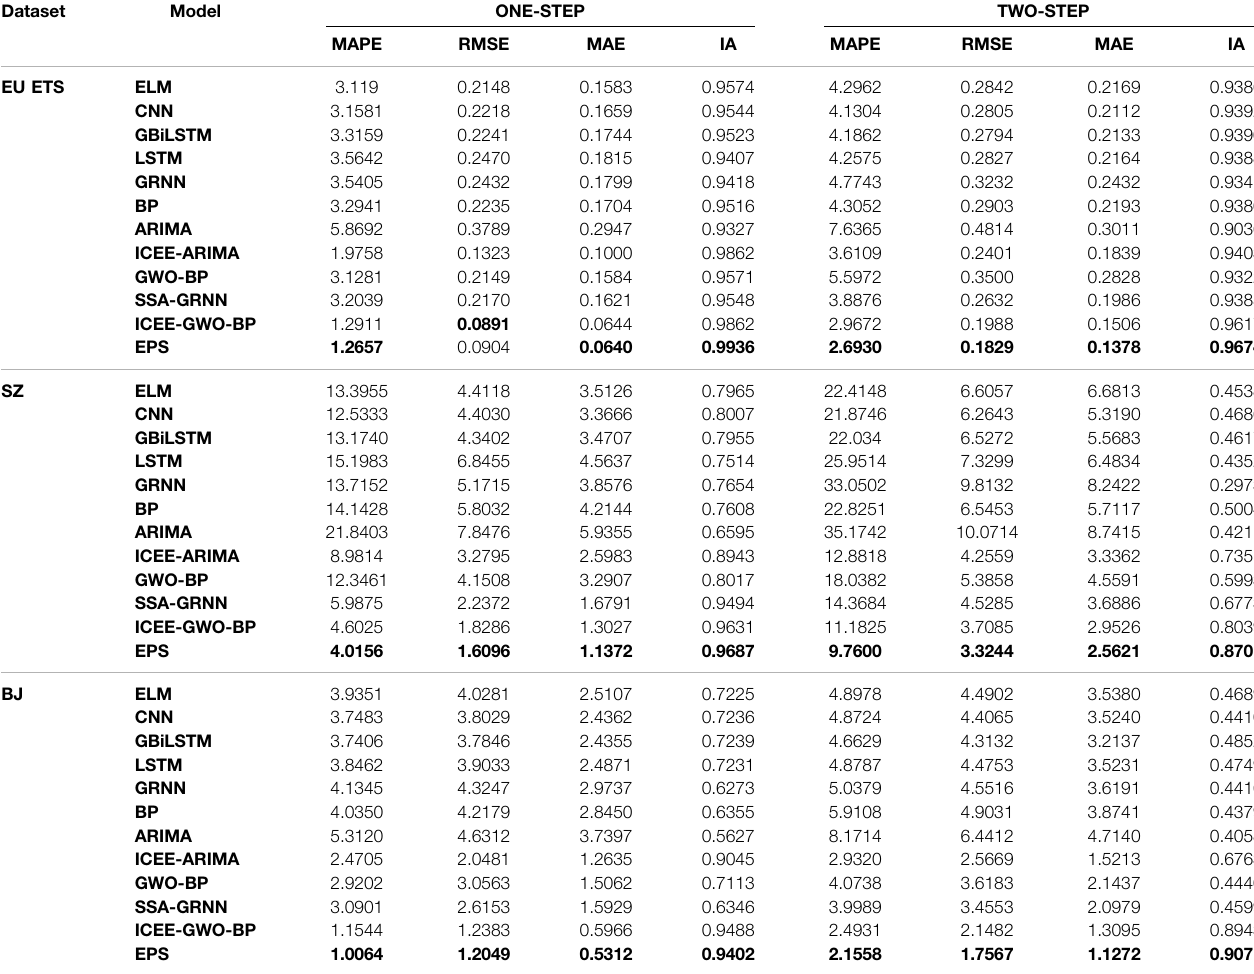
TABLE 7 | Comparison of the prediction ability of the proposed system with those of some traditional benchmark models and classic hybrid models. Dataset